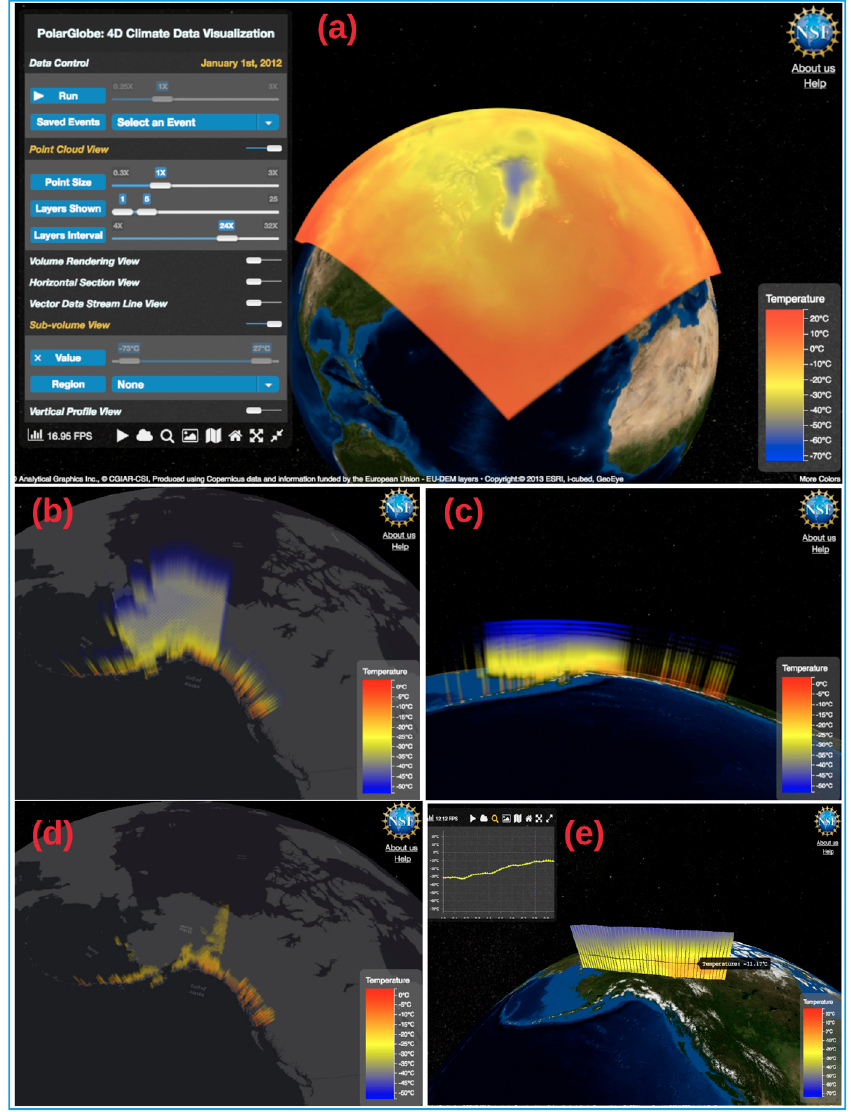
Figure 5. Graphic User Interface of PolarGlobe (http://cici.lab.asu.edu/polarglobe2): ( a ) a screenshot of temperature visualization in the whole study area; ( b ) a close look at the distribution of air temperature in Alaska, US on 1 January 2012; ( c ) a view of temperature of Alaska from the side; ( d ) the value filtering effect (Air temperature higher than − 20 degree Celsius for data presented is shown here); ( e ) the vertical profile view and statistics.